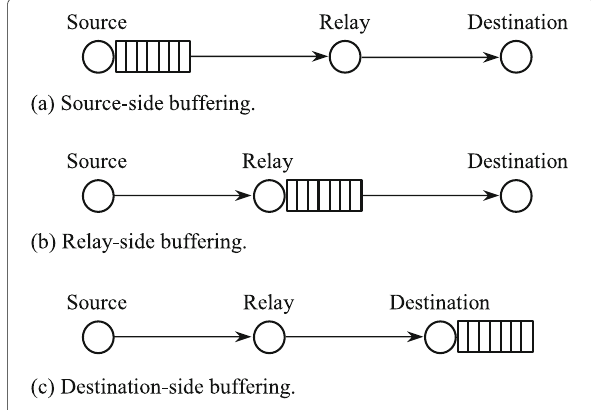
Fig. 1 Three buffering locations in buffer-aided data